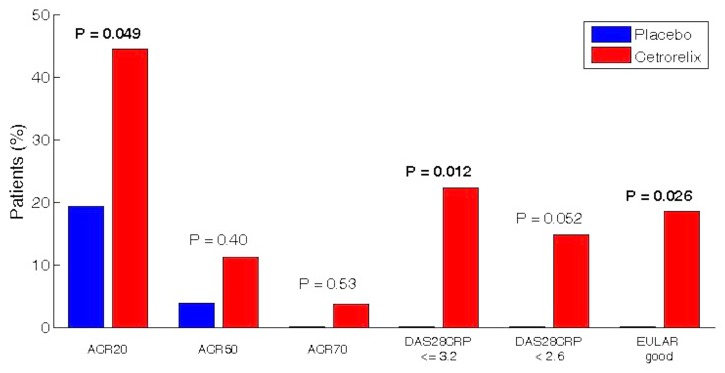
Efficacy Variables by Day 5 Between Groups.Fig 2 shows the percentage of patients achieving at least a 20%, 50%, 70% improvement in the American College of Rheumatology scale (ACR20, ACR50, and ACR70 respectively), the percentage of patients achieving ≤ 3.2 on the Disease Activity Score for 28-joint counts, based on C-reactive protein ([DAS28-CRP ≤ 3.2], in which scores range from 2 to 9, with higher scores indicating more disease activity), the percentage of patients achieving DAS28-CRP<2.6, European League Against Rheumatism ‘Good-Responses’ (EULAR good). All patients, N = 53, are included in these intention-to-treat analyses. There were no significant differences in disease activity measured by DAS28-CRP at baseline between groups.